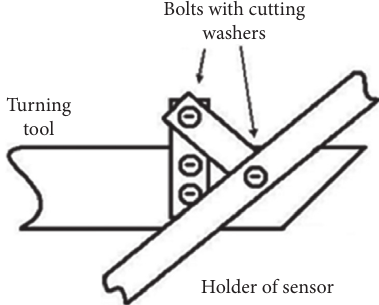
Figure 3: Construction of sensor